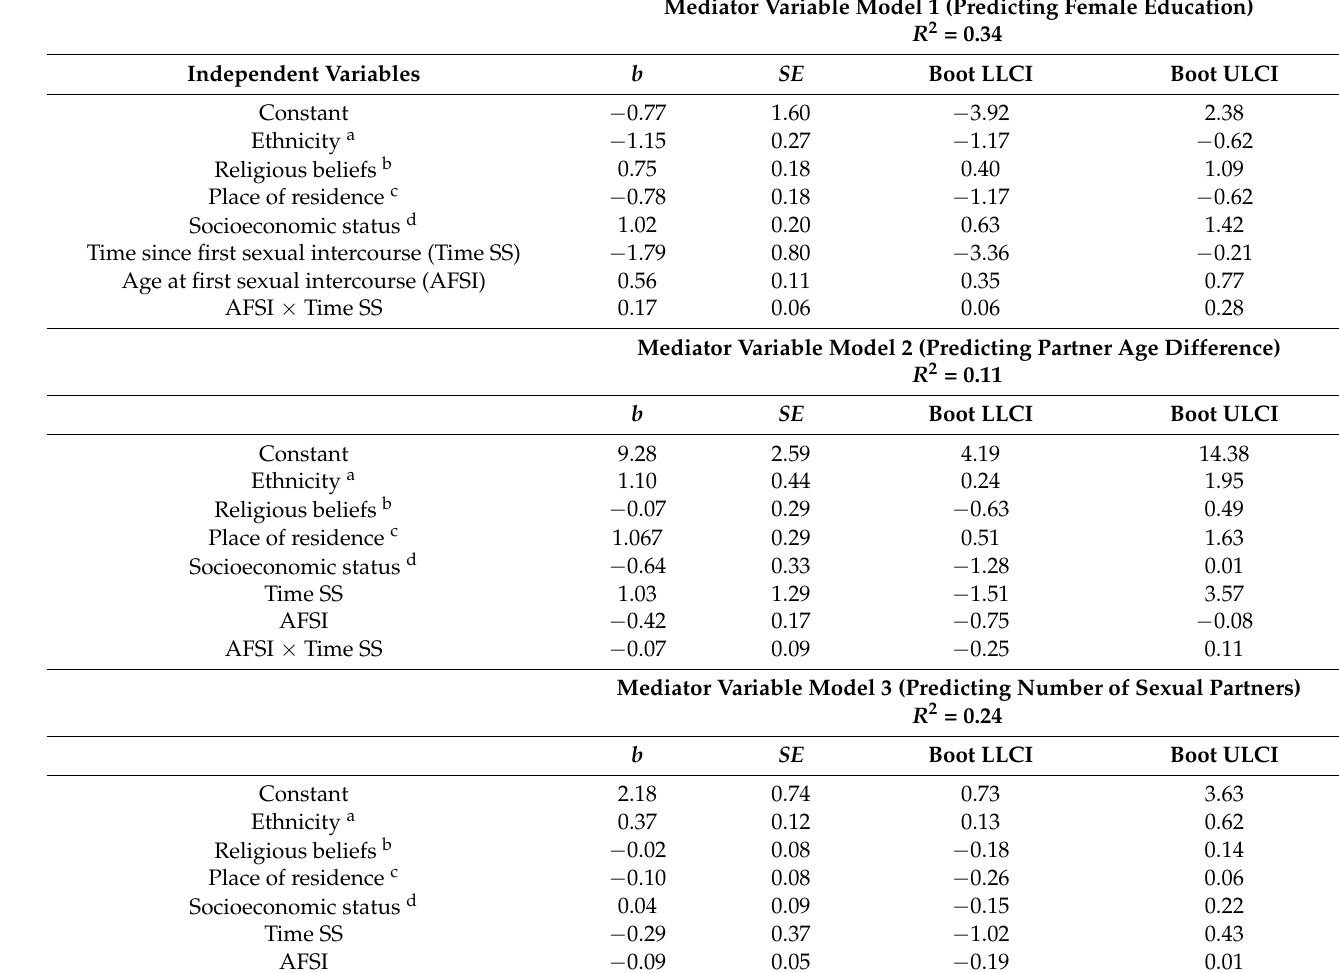
Table 3. Regression Results for the Moderated Mediation Model of the Association between Age at First Sexual Intercourse and Unintended Pregnancy through Female Education, Partner Age Difference and Number of Sexual Partners, and Conditional Indirect Effects at Different Values of the